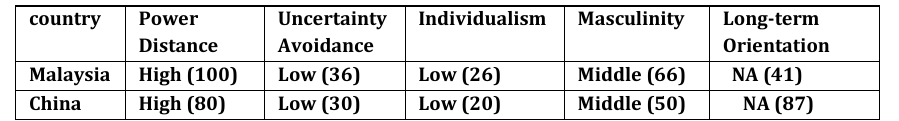
Table 1: The national cultural / value dimensions in